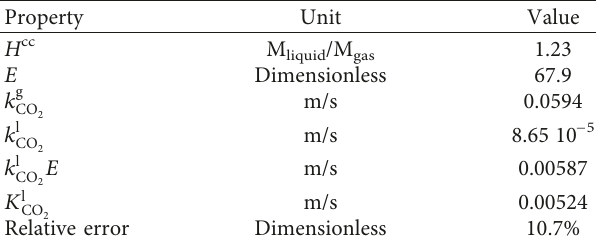
2 mass transfer